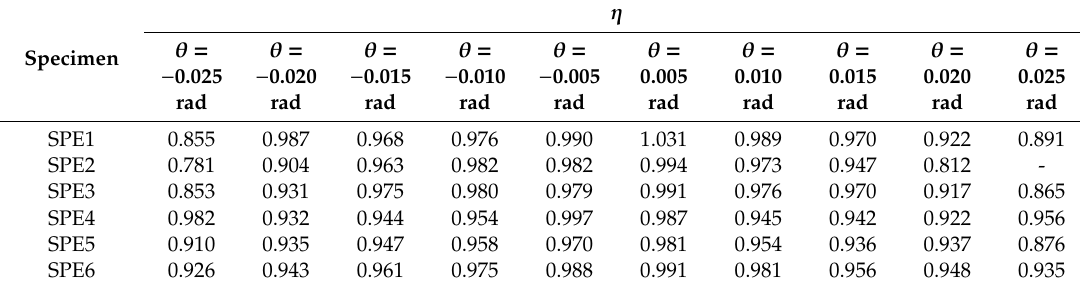
Figure 14. Strength degradation curves. Table 6. Values of η on main